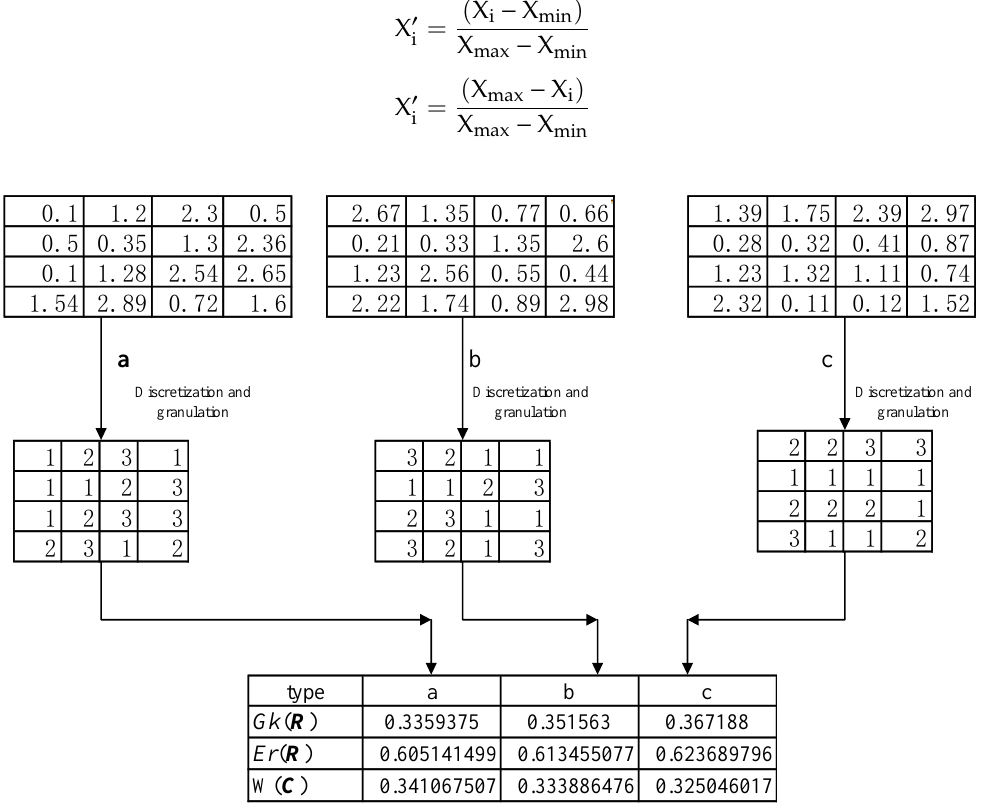
Figure 1. Calculation process of the eco-environment factor weight based on knowledge granulation Figure1. entropy.